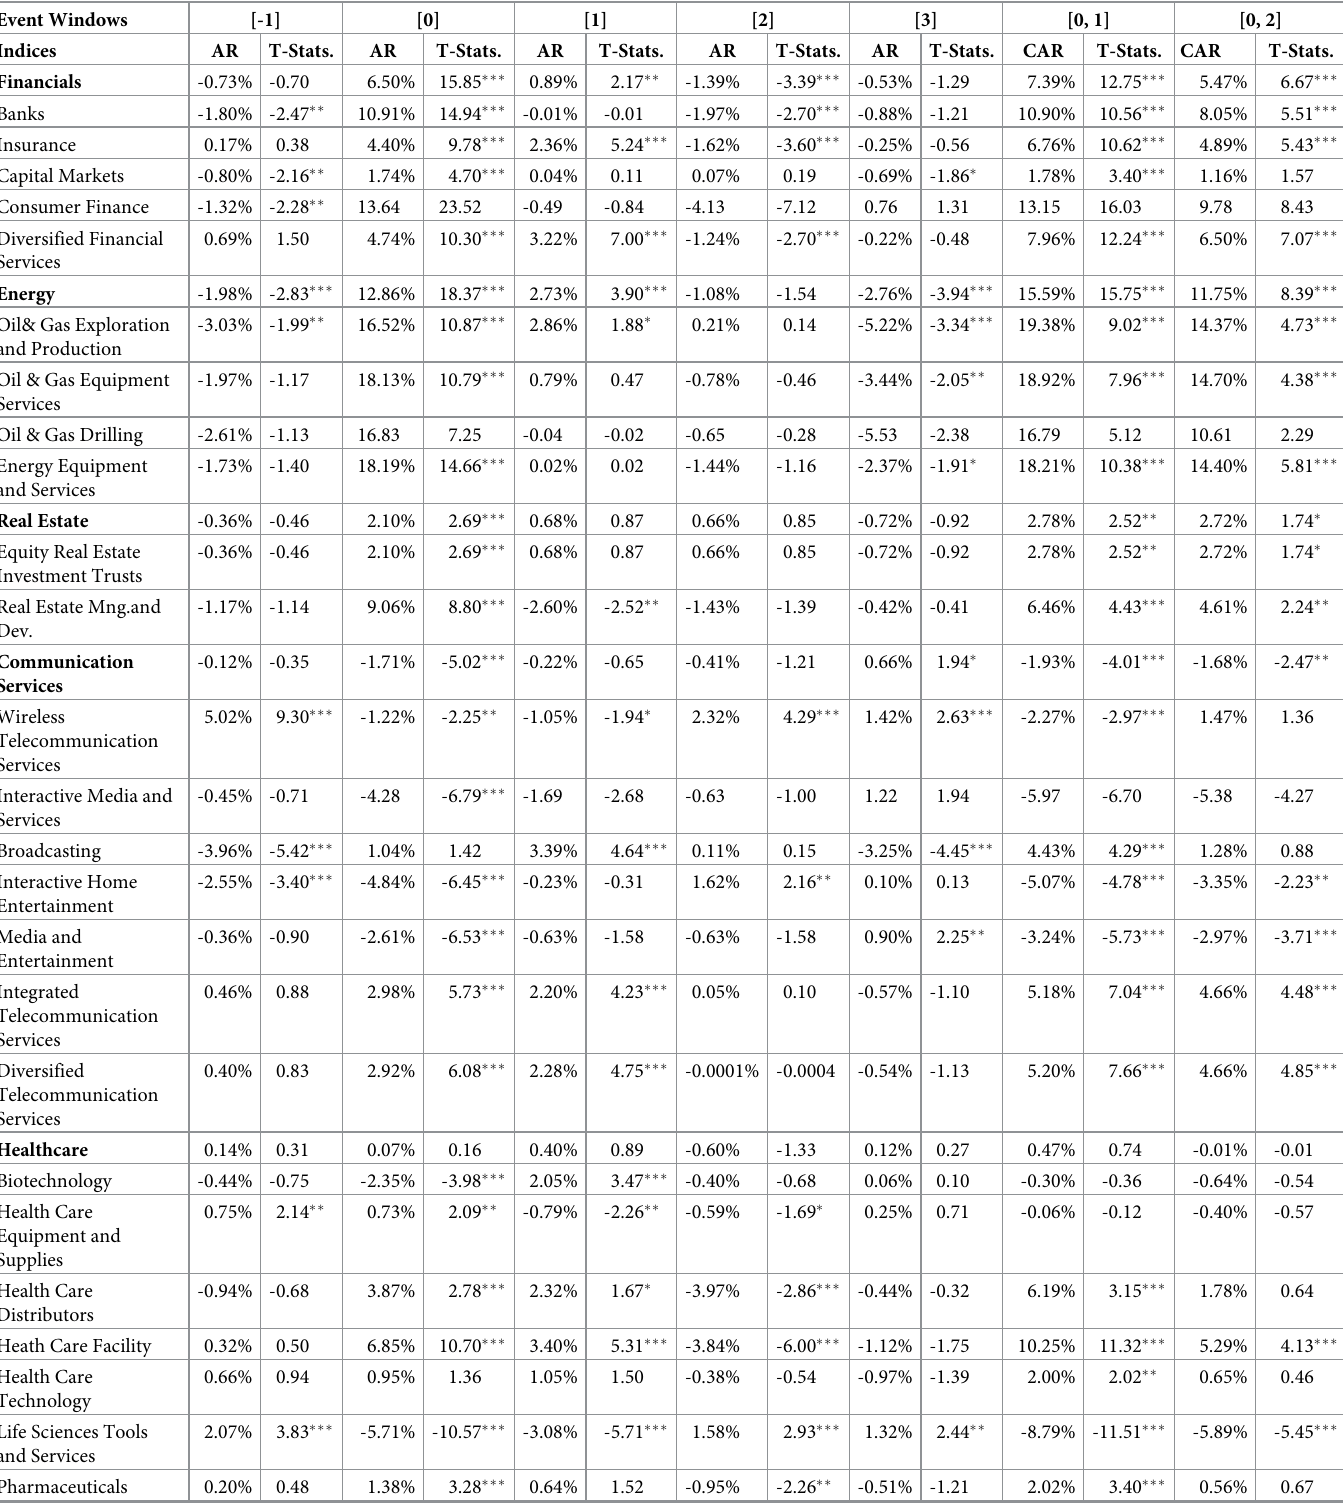
Table 3. Market model abnormal return and cumulative abnormal return for different event windows-estimation period: 10 September 2019–16 January 2020. Event